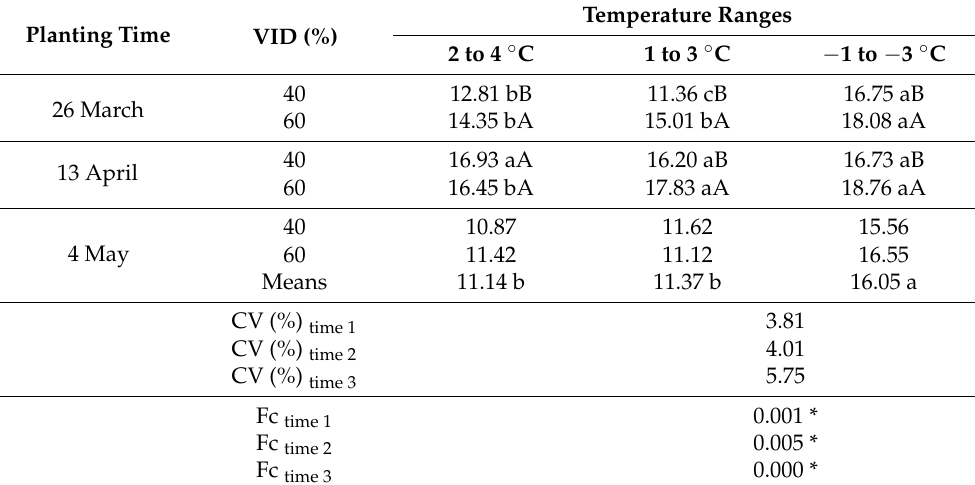
Table 7. Productivity of garlic (t ha − 1 ) plants of the Ito variety, under different temperatures ranges and visual index of overcoming dormancy (VID).